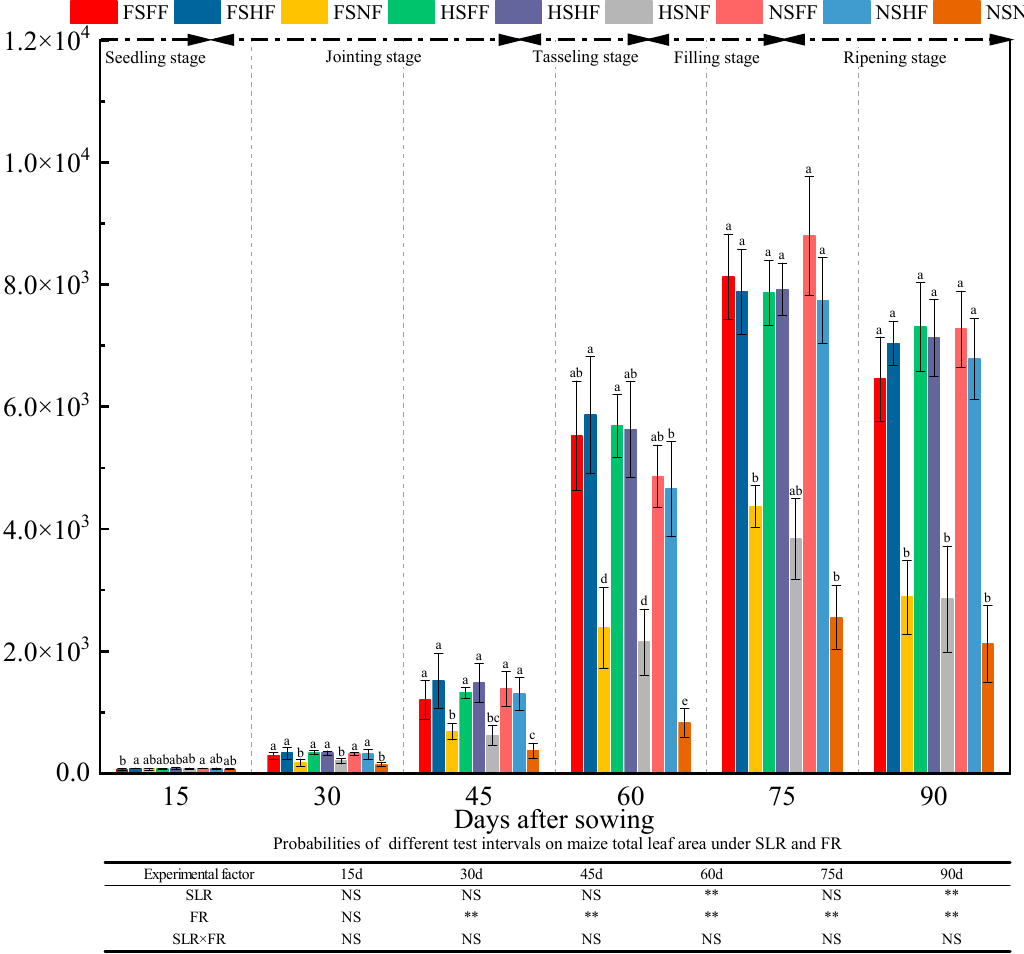
Figure 4. Effects of SLR and FR on total leaf area. Note: Bars represent means ± standard deviation ( n = 3) with different letters indicating significant differences based on LSD ( p ≤ 0.05). SLR, sugarcane leaf return; FR, fertilizer reduction.